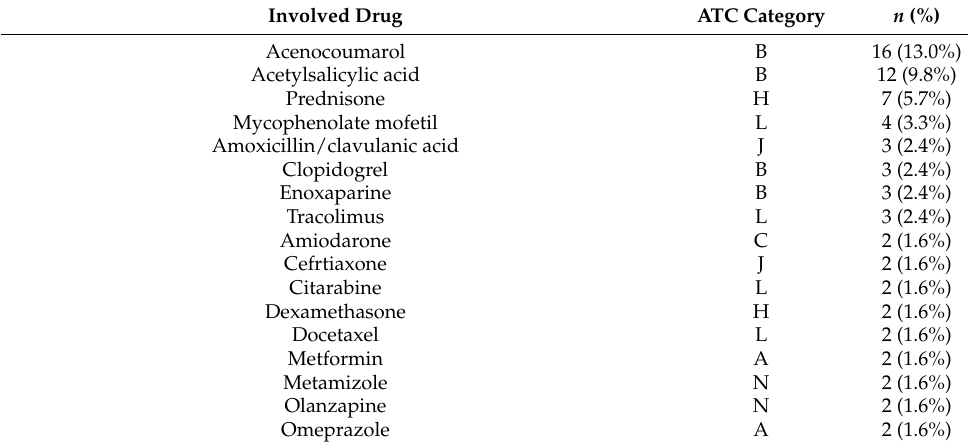
Table 5. Drugs involved in